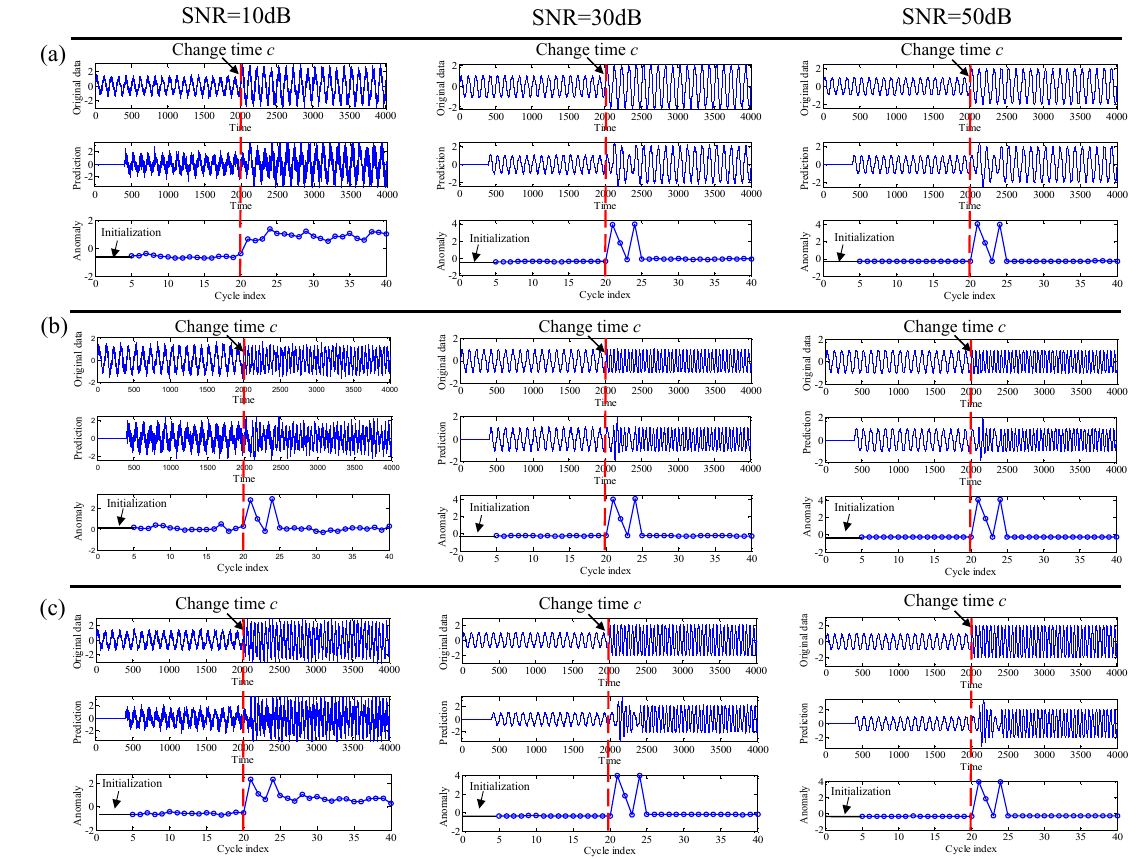
Figure 1. Results on testing data containing different changes: ( a ) amplitude change; ( b ) frequency change; ( c ) amplitude and frequency